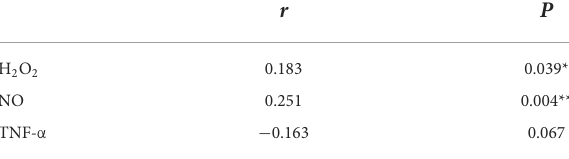
TABLE 7 Correlations of the levels of free radicals and neuroinflammatory factors with neuropathological proteins in CSF from the PD-NPSs